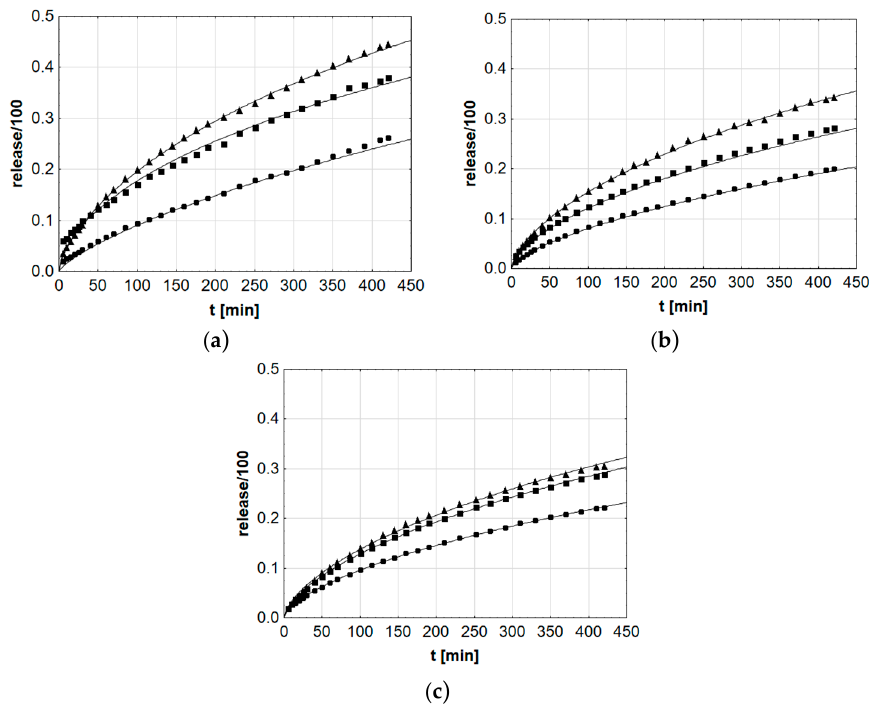
Figure 7. Courses of mean β E release in the Weibull model evaluated in Statistica application, applied to formulations ( a ) MC, ( b ) PA1, and ( c ) PC-11, ▲ —reference gel, ■ —20% of MSA, ● —40% of MSA.